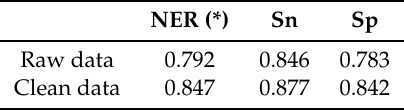
Table 3. Sediment test results summary.